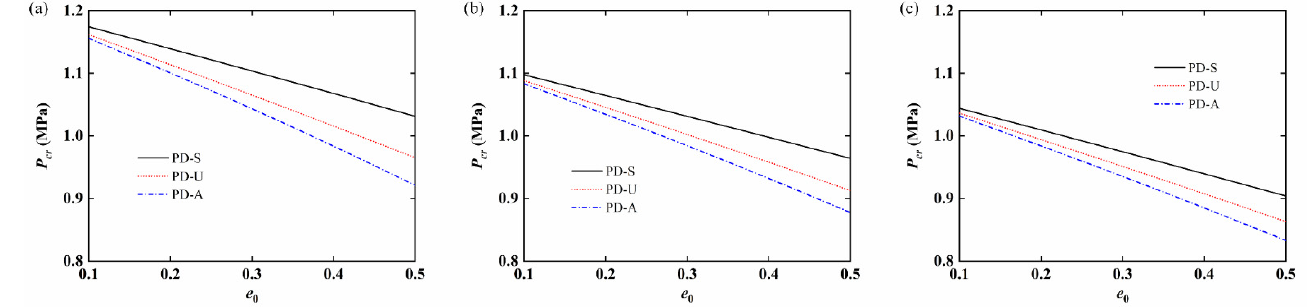
Figure 10. Variations in critical pressure of ring-stiffened porous GPLRC cylindrical shells with porosity coefficients for different porosity distributions ( a ): GPL-S; ( b ): GPL-U; ( c ): GPL-A. Figure 11 shows the variation in the critical pressure with the length-to-thickness ratio l GPL / t GPL of the GPLs under different length-to-width ratios l GPL / w GPL of the GPLs. It can be observed that the critical pressure first increased with the increase in the l GPL / t GPL , and then tended to remain unchanged. The critical pressure of ring-stiffened porous GPLRC cylindrical shells was higher for the lower length-to-width ratios l GPL / w GPL .